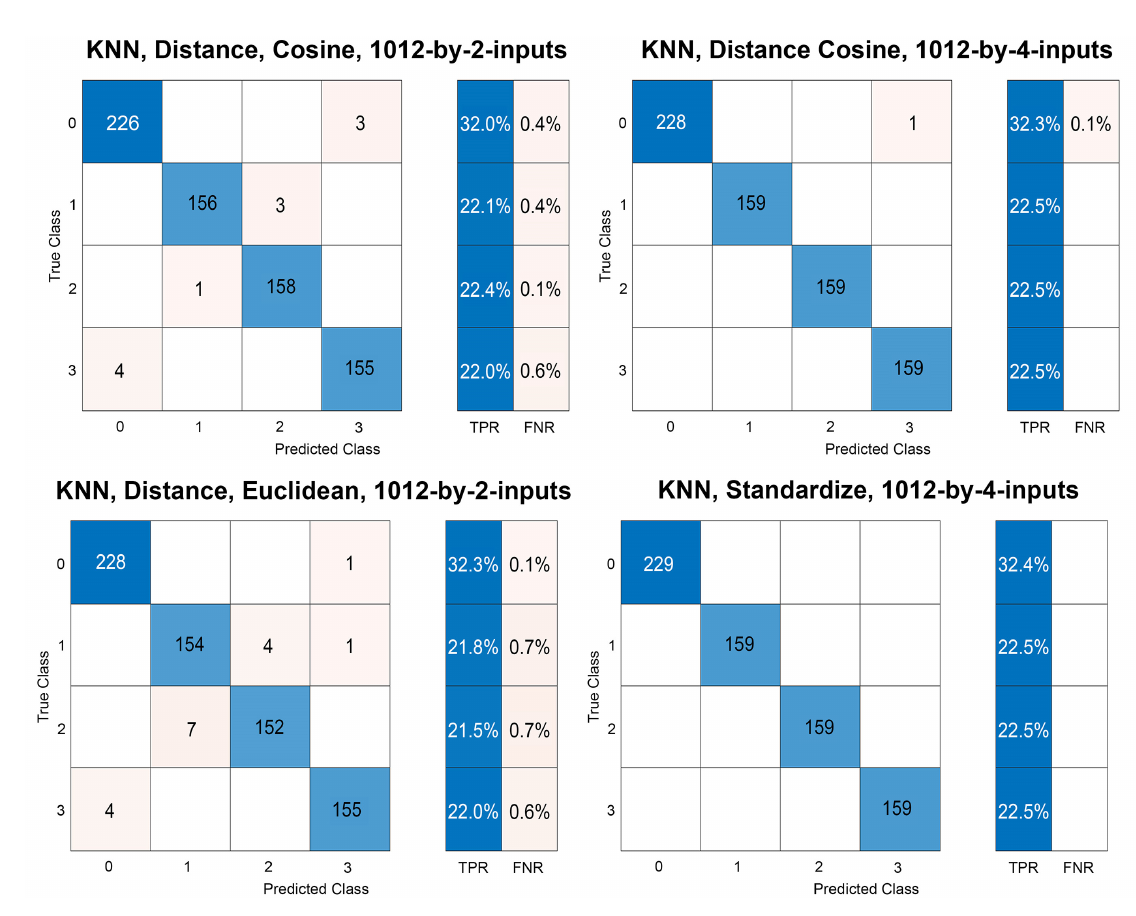
Figure 8. Confusion charts of ECOC